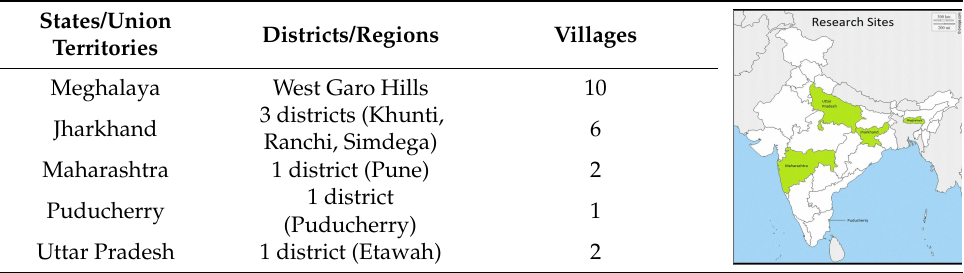
Table 1. Research